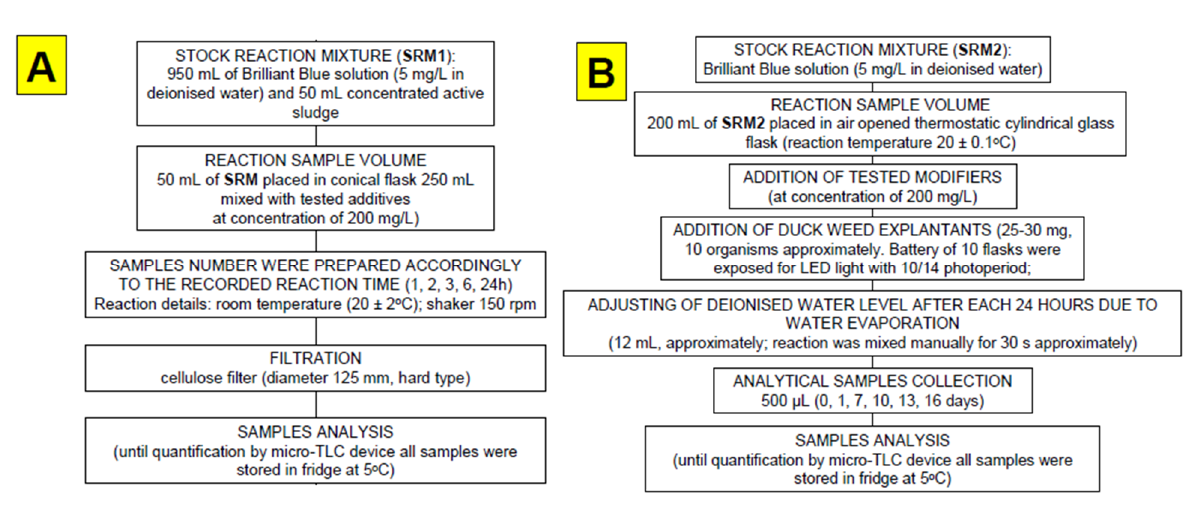
Figure 2. Sequence and protocol details of 24 h ( A ) and 16 day ( B ) tests.